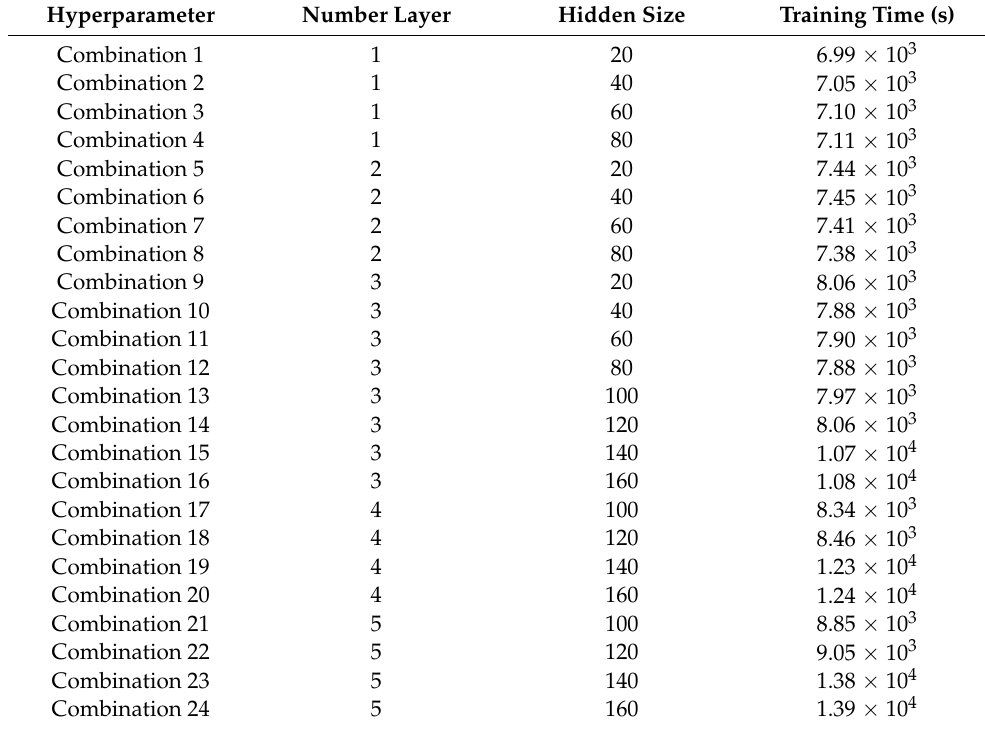
Table A1. LSTM neural network different hyperparameter combination and running